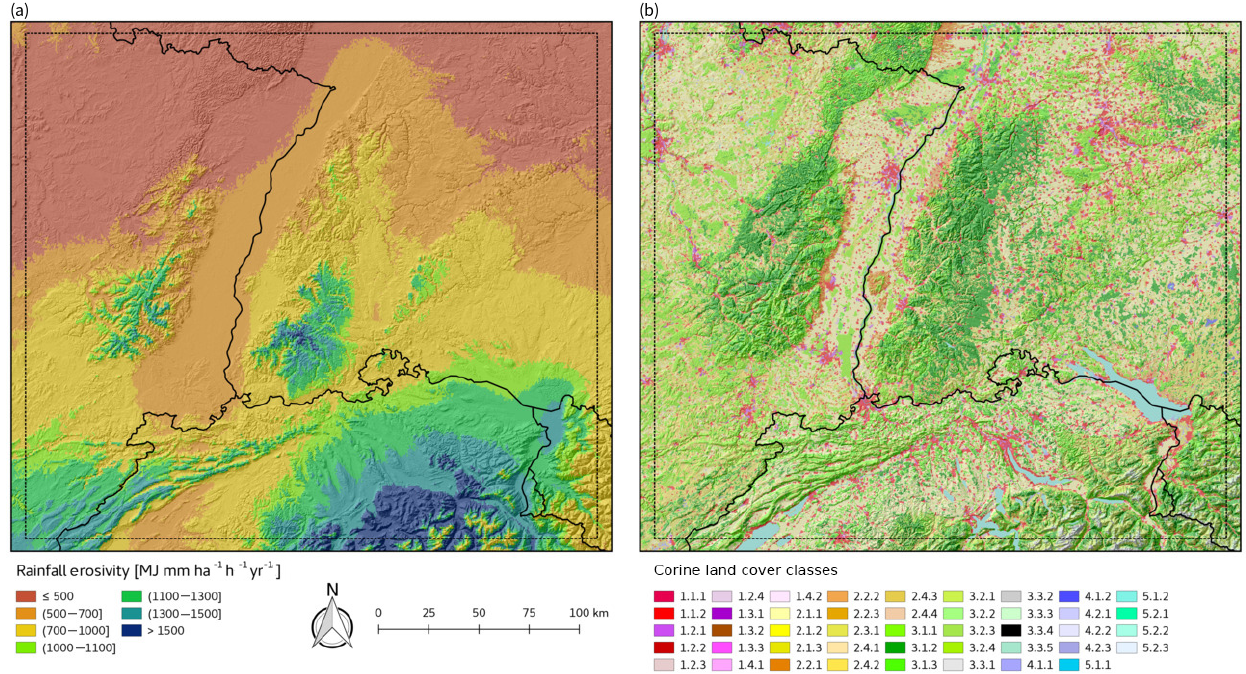
Figure 6. (a) Erosivity and (b) land cover in the target